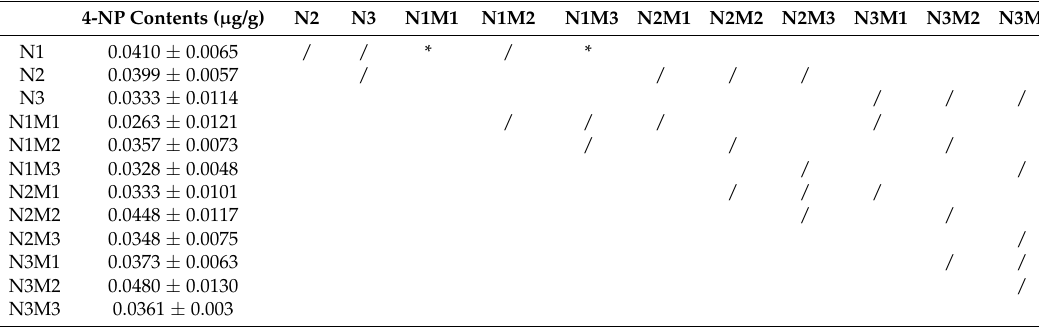
Table 8. Statistical analysis of 4-NP contents in muscle at Day 30.